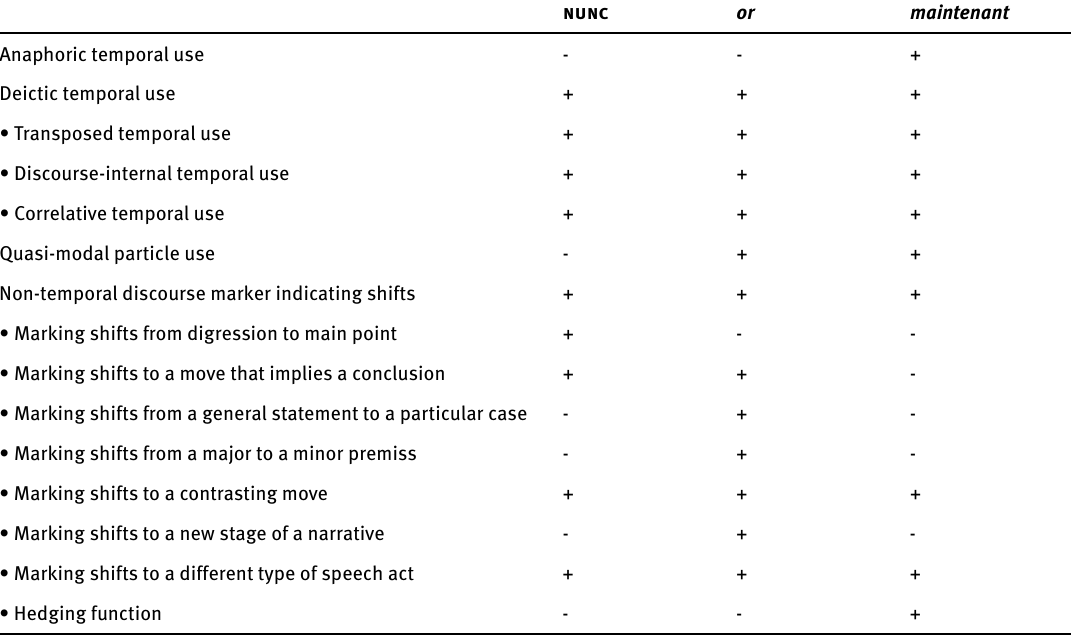
Table 1: Uses of nunc, or , and maintenant nunc or maintenant Anaphoric temporal use - -